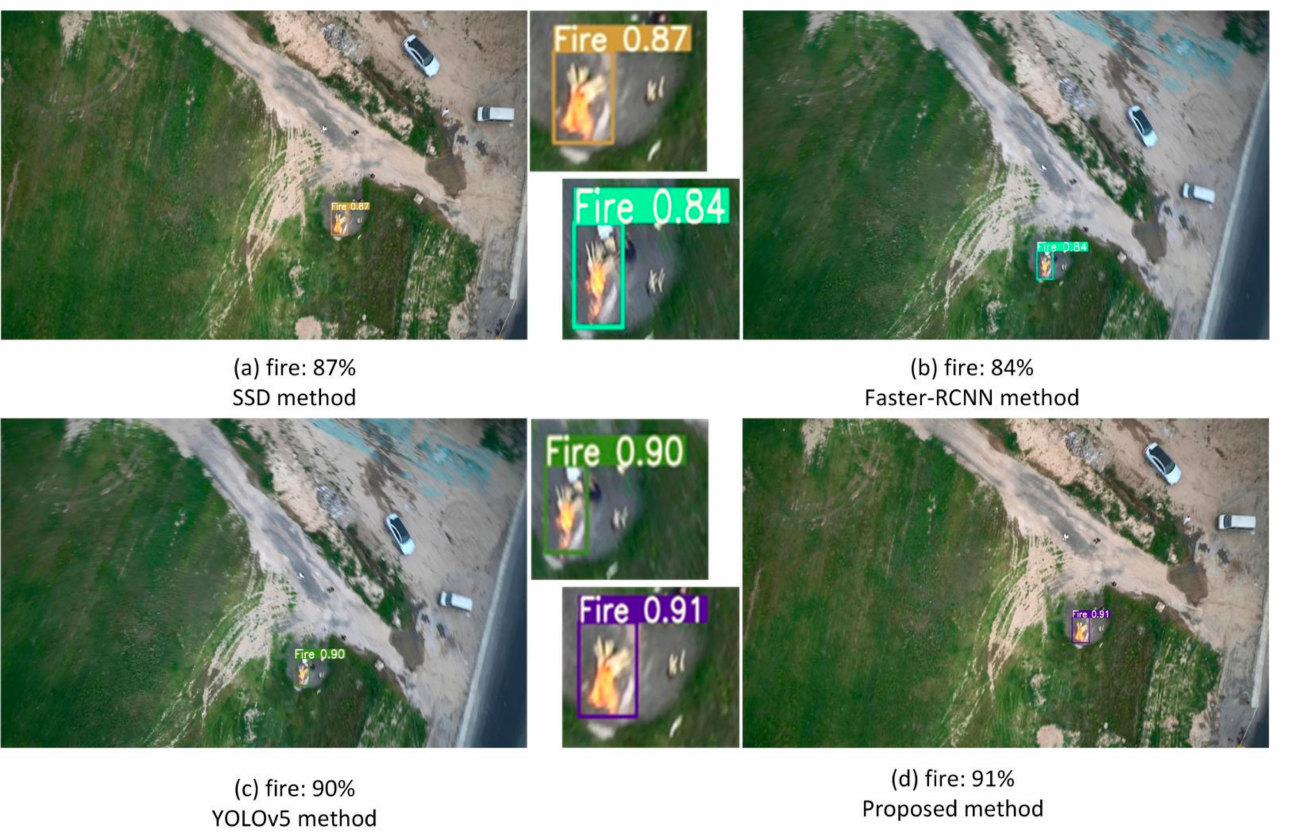
Figure 10. Fire detection at a long